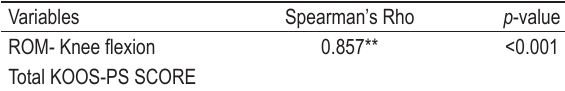
TABLE 3. Spearman correlation coefficient (Spearman’s Rho) of knee